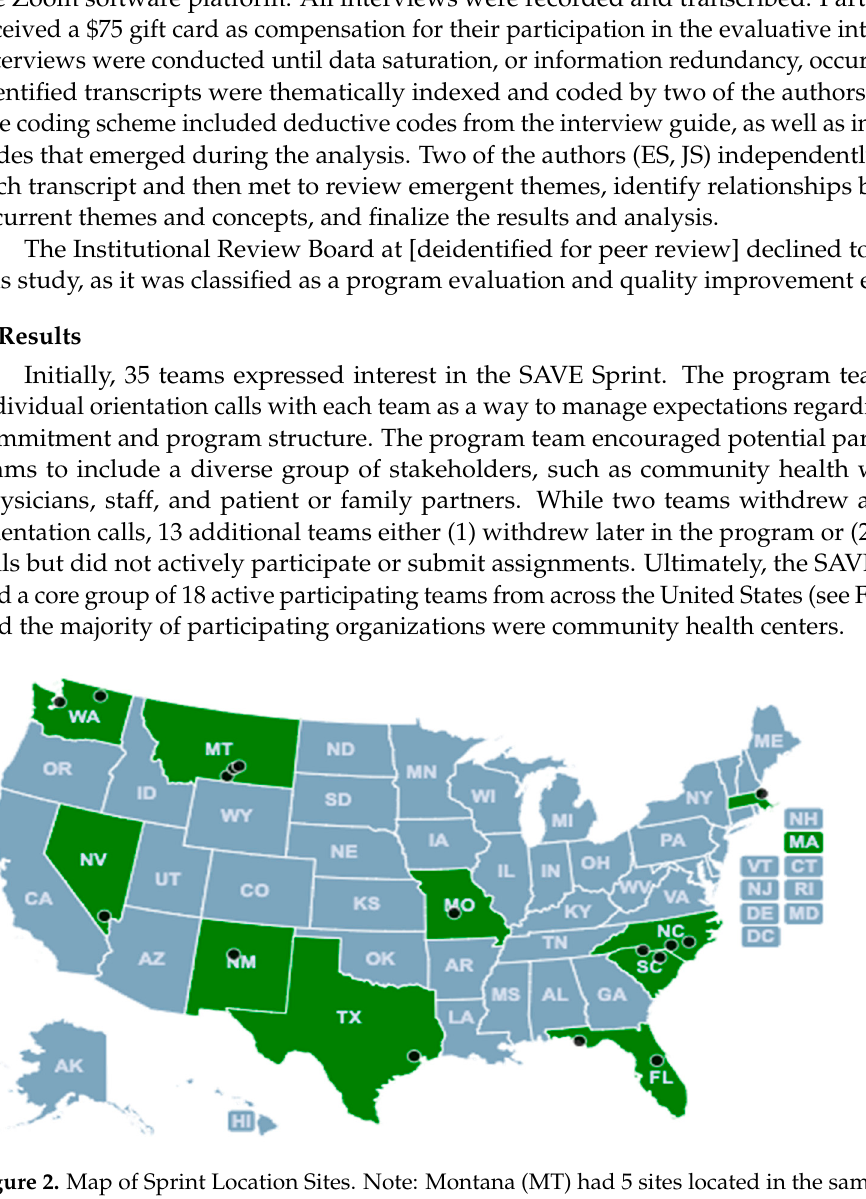
Figure 2. Map of Sprint Location Sites. Note: Montana (MT) had 5 sites located in the same region; 2 site markers in MT represent 2 sites instead of one.